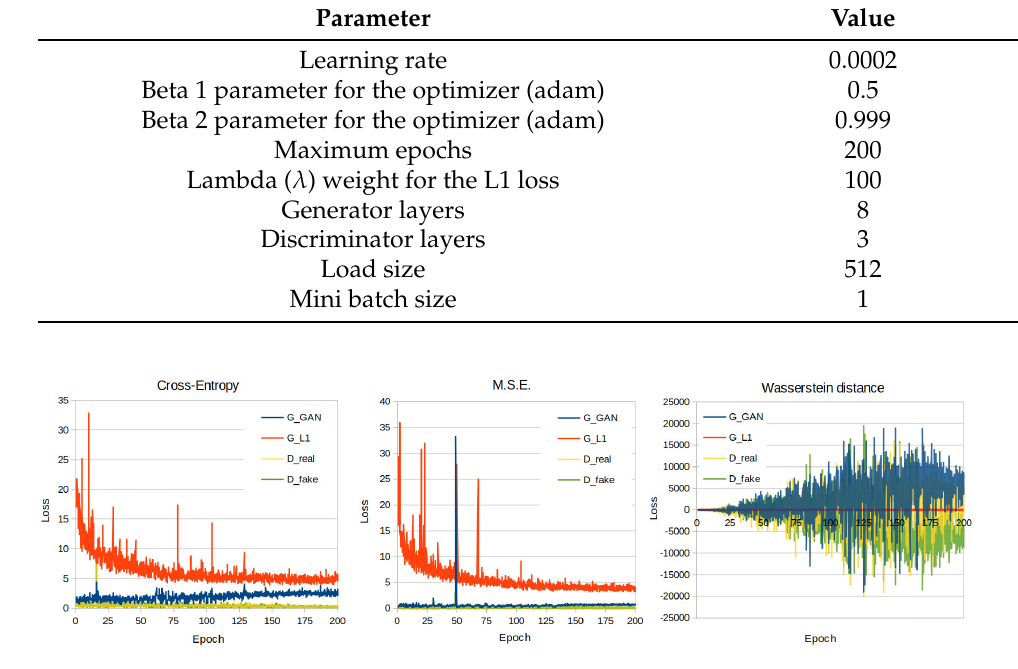
Figure 5. Training loss curves of the cross entropy, M.S.E. and Wasserstein distance loss function